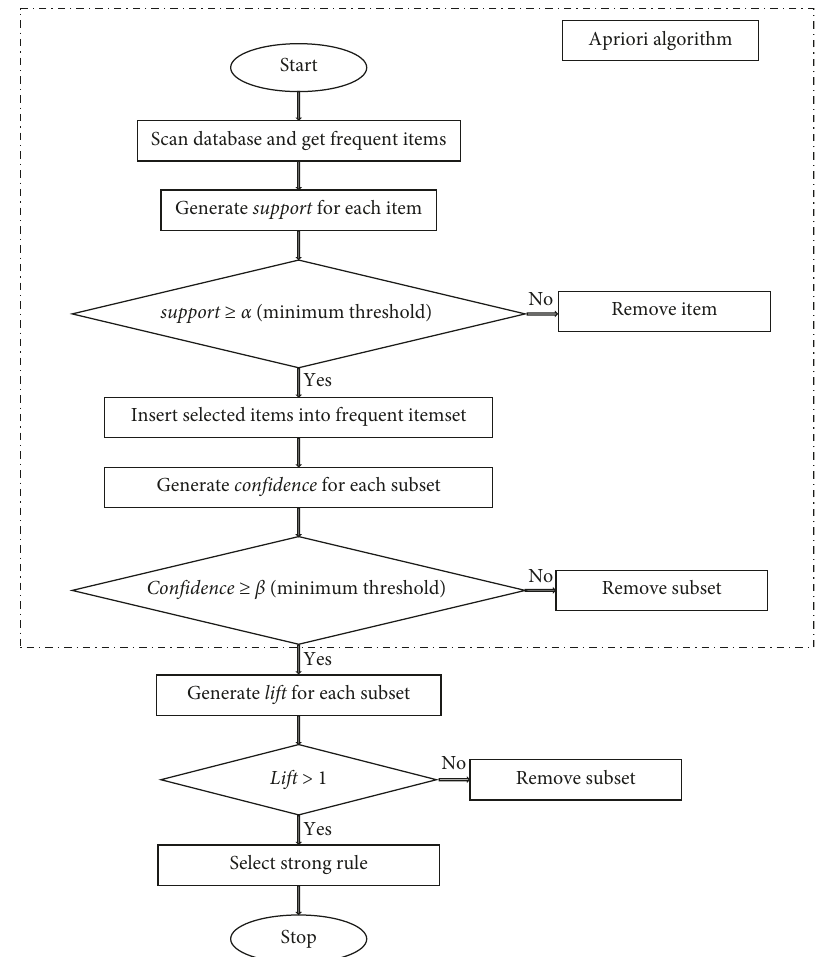
Figure 1: Flowchart of the association rule mining process. Table 2: Number of rules by combination of minimum support and